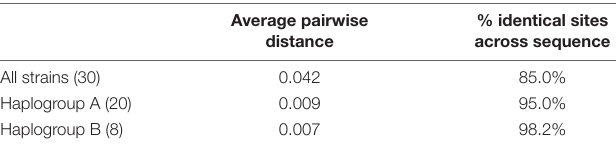
Number of strains indicated in parentheses for each calculation. Aligned using Muscle and genetic distances calculated in Mega7, using the pairwise distance function. Identical sites determined in